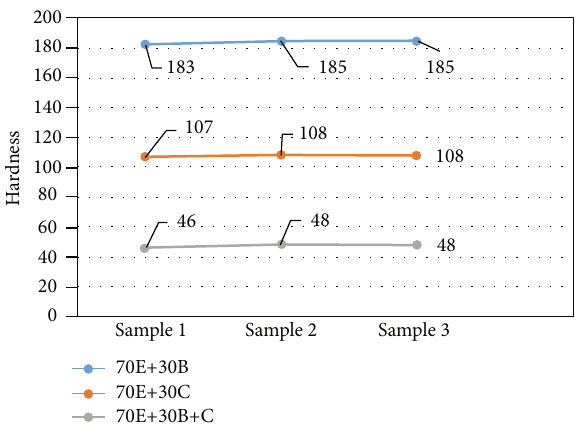
Figure 4: Samples testing for hardness (HRC).